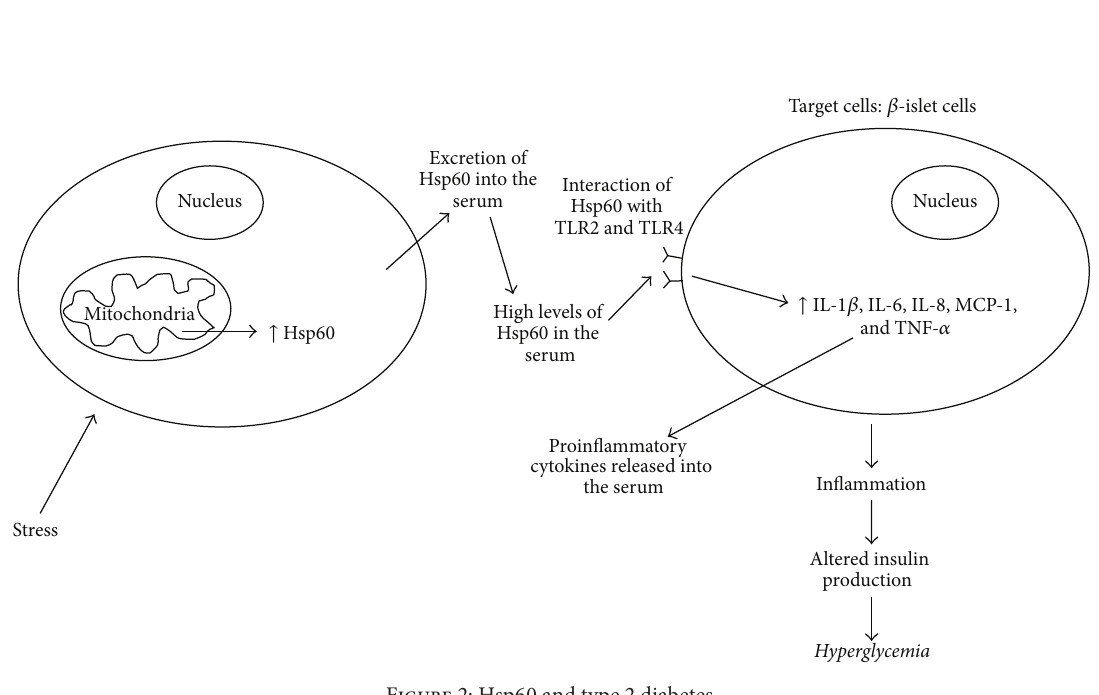
Figure 1: Hsp60 and type 1 diabetes.